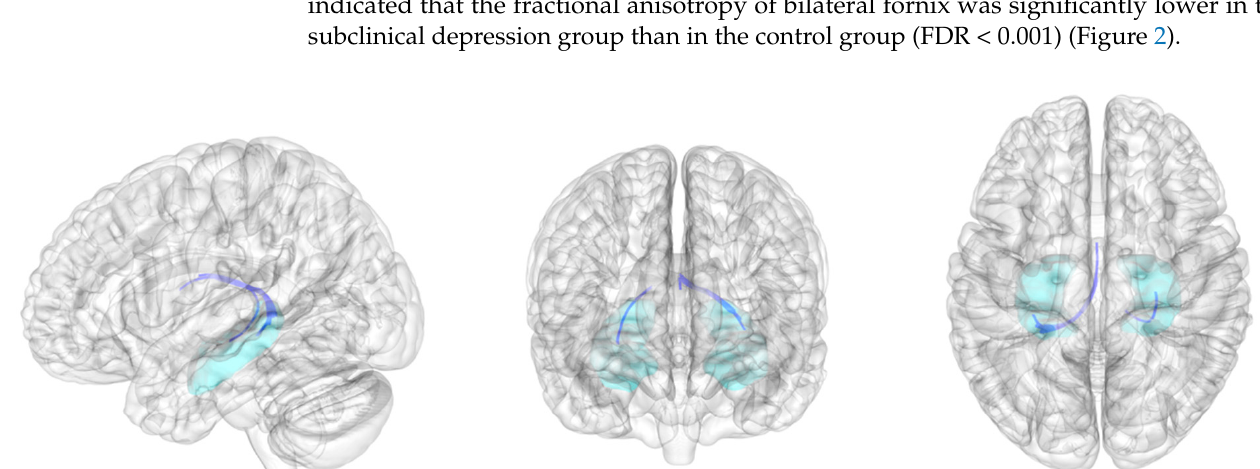
In the exploratory analysis of whole brain connectometry, the majority of bilateral fornix fiber bundles exhibited lower fractional anisotropy in the subclinical depression group (Figure S1). Connectometry analysis using the hippocampus as the seed region also indicated that the fractional anisotropy of bilateral fornix was significantly lower in the